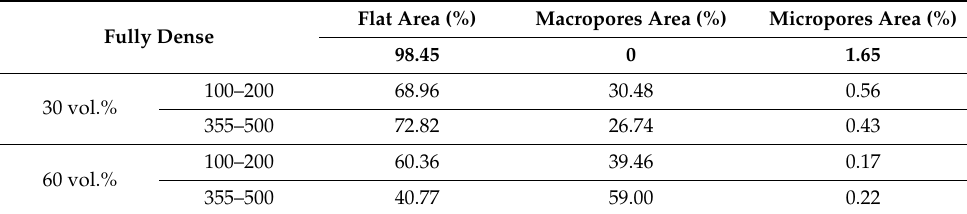
Table 2. Distributions occupied area of titanium discs surface obtained by image analysis: flat area, macropores and